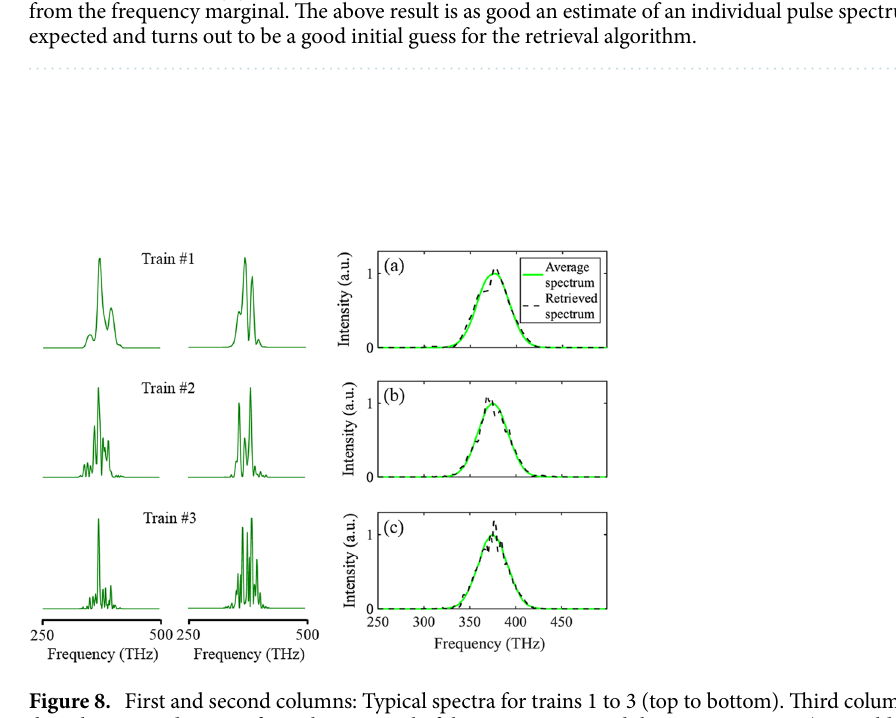
Figure 8. First and second columns: Typical spectra for trains 1 to 3 (top to bottom). Third column: The directly retrieved spectra from the marginal of the FROG trace, and the average spectra (as would be measured by a spectrometer averaging over all pulses in the train) for the three trains with average ( a ) τ FWHM = 26 fs, ( b ) τ FWHM = 54 fs, and ( c ) τ FWHM = 108 fs. The discrepancy between these two spectra increases as the instability increases in the train, which is caused by the instability-induced deviation of the frequency-marginal curve from the autoconvolution of the average spectrum of the trains. Indeed, the spectral structure shown here is indicative of the structure actually present in a typical pulse in each train and so is a better estimate of the typical pulse spectrum than the average